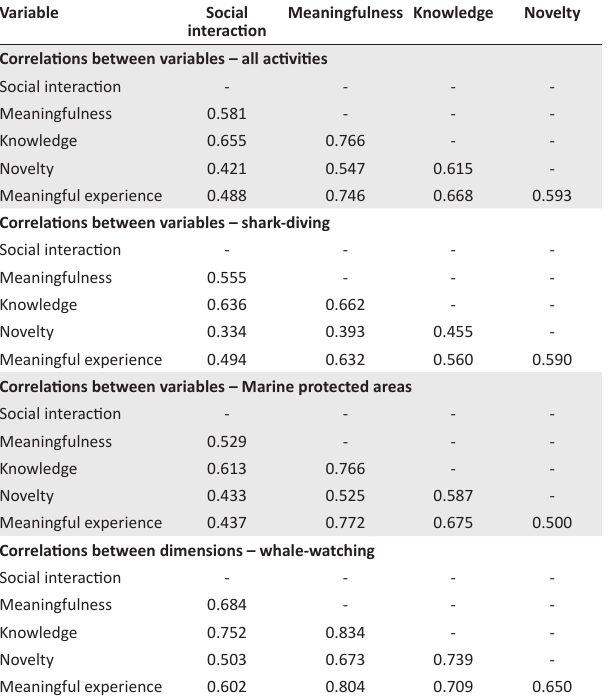
TABLE 3: Correlations between variables – All activities. Variable